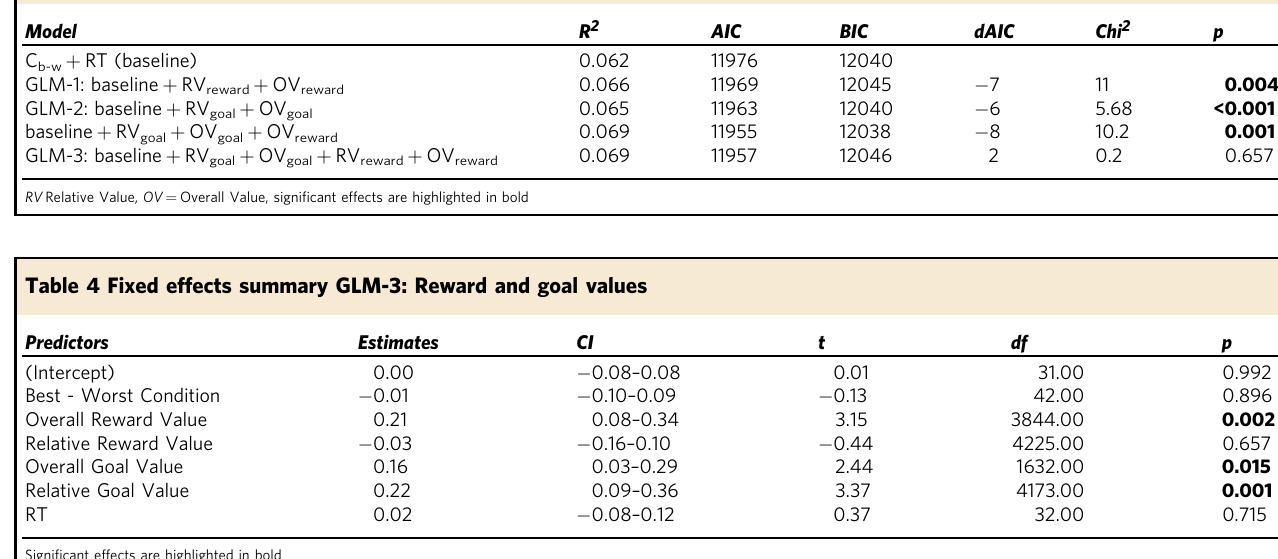
Signi fi cant effects are highlighted in